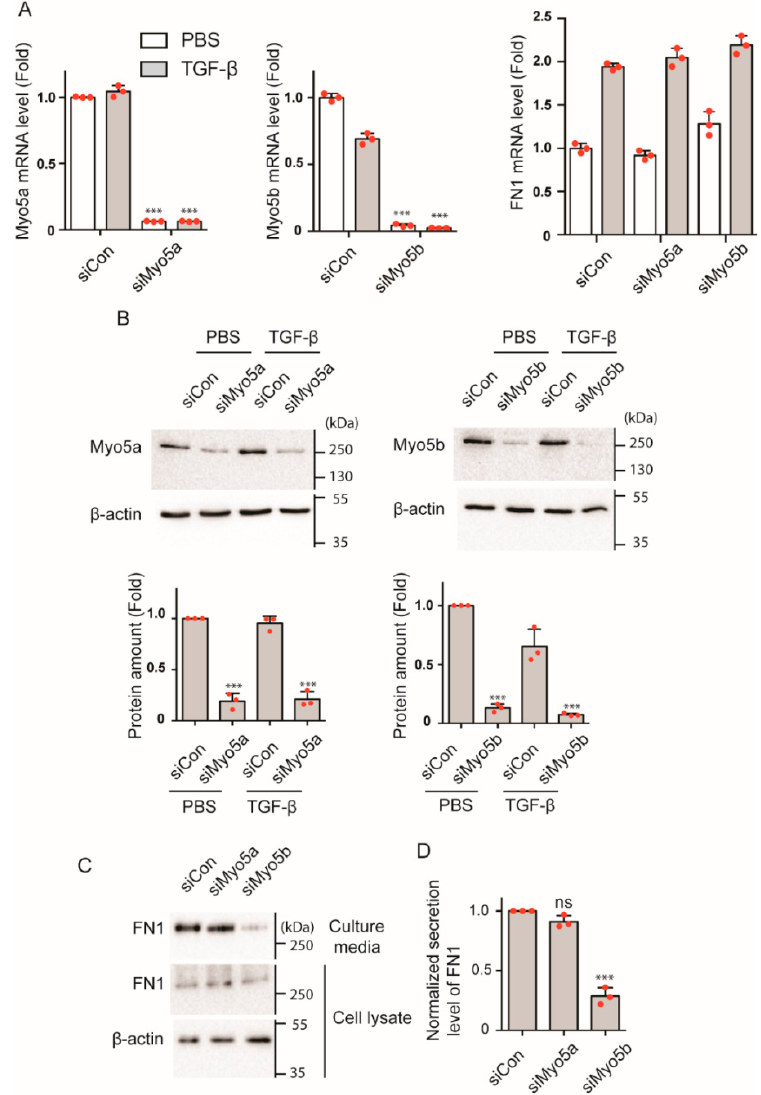
Figure 5. Effect of Myo5b KD on secretion of FN1 from HPMCs. ( A ) Effect of gene silencing of Myo5 isoforms on mRNA level of Myo5 and FN1 by specific siRNAs. mRNA expression was examined by qPCR analysis. siCon, control siRNA; siMyo5a, Myo5a specific siRNA; siMyo5b, Myo5b specific siRNA. n = 3, *** p < 0.001 vs. siCon. ( B ) Effect of gene silencing of Myo5 isoforms on Myo5 protein expression level in cell lysate. Top, representative Western blots; Bottom, statistical representation of Western blot signal intensities ( n = 3, mean ± SD). *** p < 0.001 vs. siCon. Full-length blots were presented in Supplementary Figure S2. ( C ) Effect of Myo5 KD on FN1 secretion. Representative image of Western blot analysis of FN1 protein amount in cell lysate and culture media. Control siRNA and Myo5a or Myo5b specific siRNA transfected HPMCs were serum starved for 8 h and cells were then treated with TGF- β (5 ng/mL). The cell lysate and culture media were collected at 4 days after TGF- β stimulation. The culture media were changed at 24 h before collecting the culture media for determination of secreted FN1 and the culture supernatants were subjected to Western blot analysis. Full-length blots were presented in Supplementary Figure S2. ( D ) Statistical representation of normalized secreted level of FN1 after TGF- β stimulation ( n = 3, mean ± SD). *** p < 0.001. ns, not significant. The red spots in bar graphs display the distribution of data points.